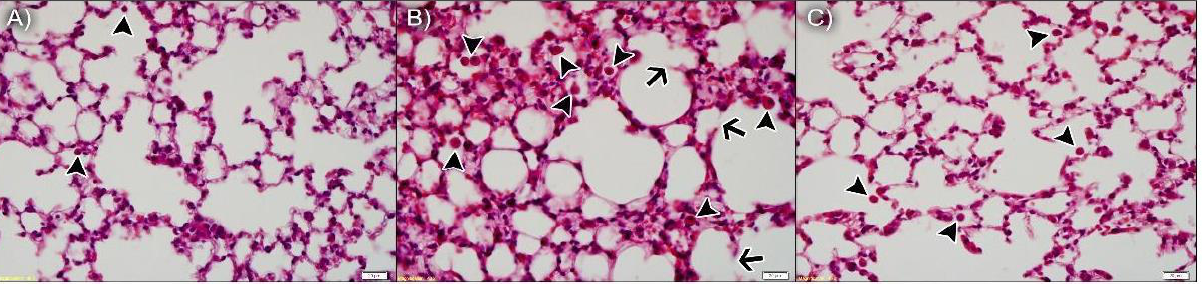
Figure 4. Bixin-loaded nanoparticles protect against CS-induced leukocyte infiltration and onset of structural damage in the lung parenchyma. Histological slides stained with H&E from AA + npBL ( A ), CS + npBL ( B ) and CS + npBX 18% ( C ) groups. Arrowheads indicate leukocyte infiltration. Arrows represent early stages of alveolar septa disruption. Scale bar: 20 µ m. Original magnification: 40 × .